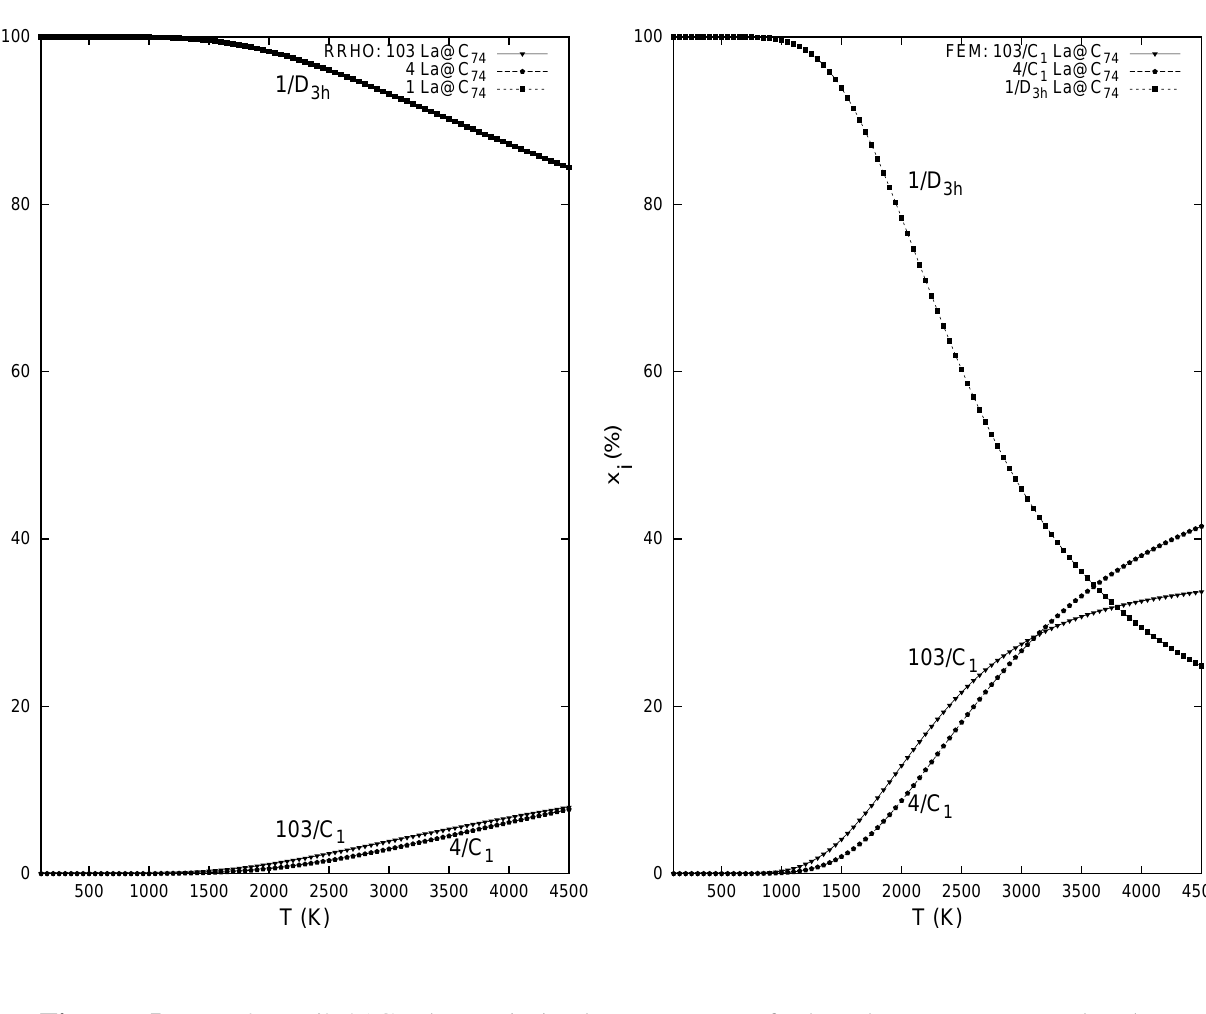
isomers computed with the 74